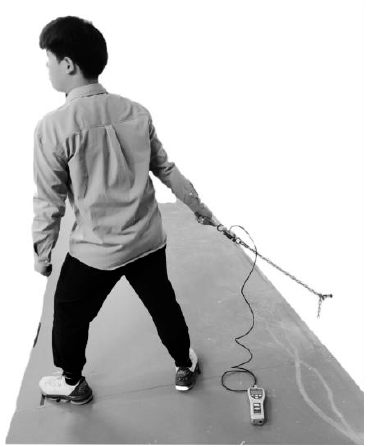
Figure 2. PS measurement.